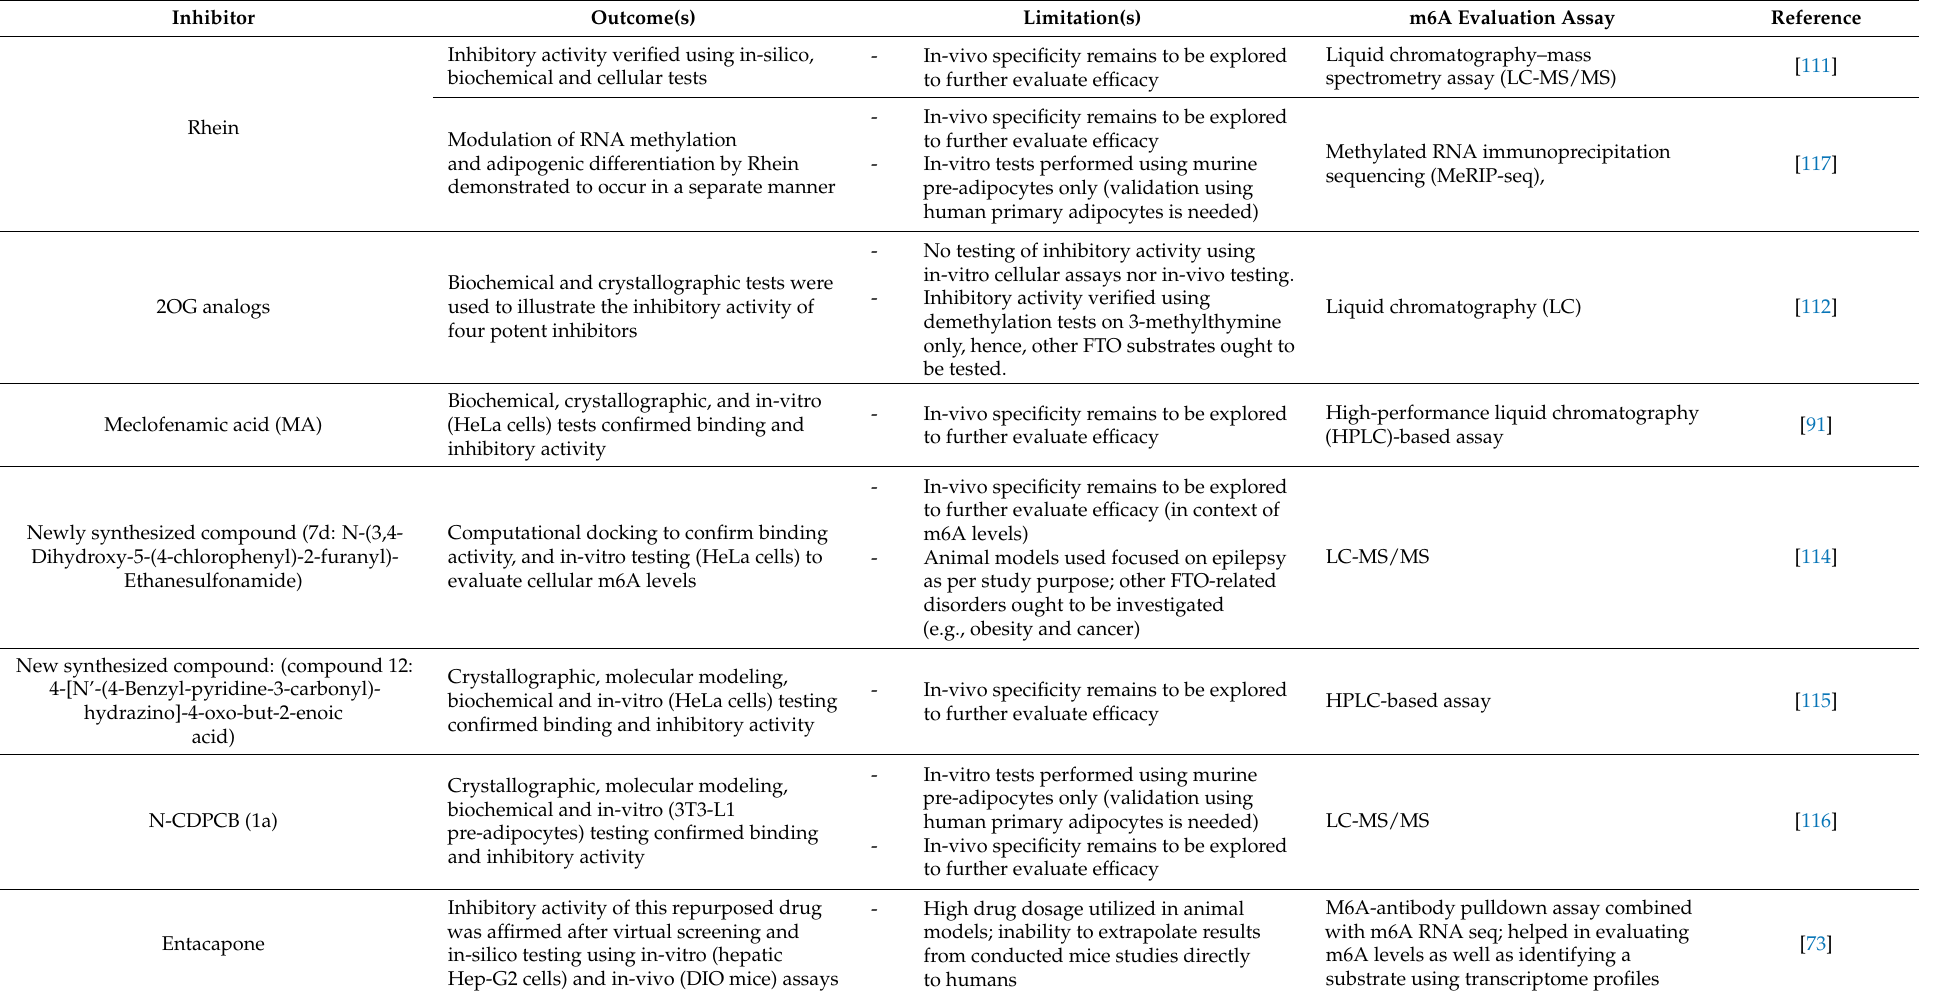
Table 2. Reported biochemical inhibitors of FTO enzymatic